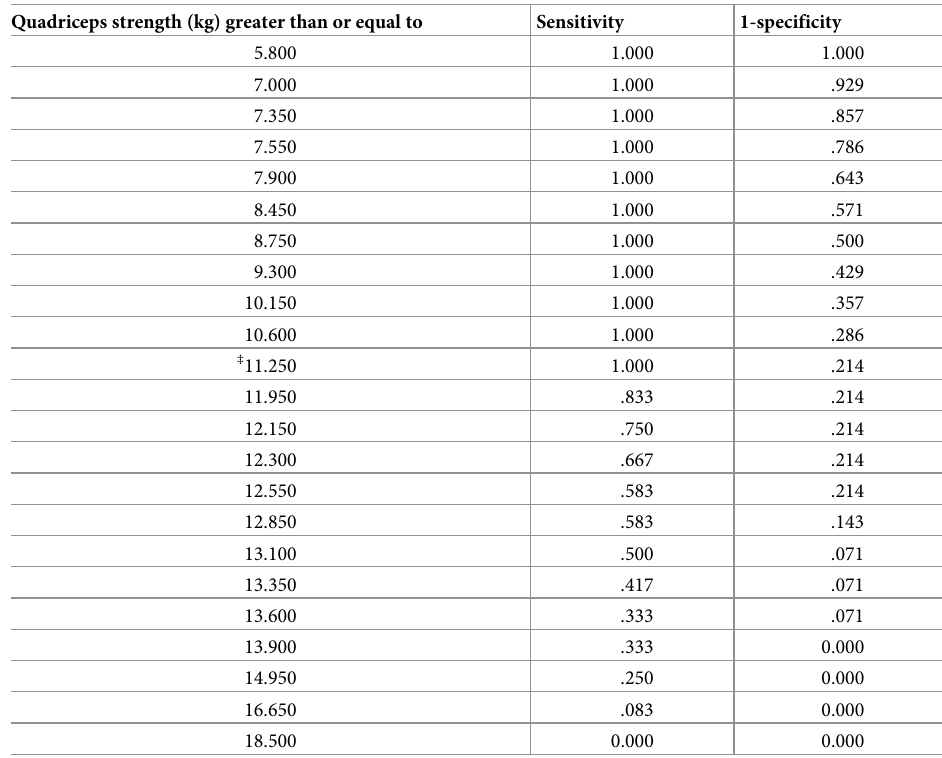
Table 4. Coordinates of ROC curve analysis for accuracy of quadriceps strength in detecting residents of nursing homes dependent in ADL. Quadriceps strength (kg) greater than or equal